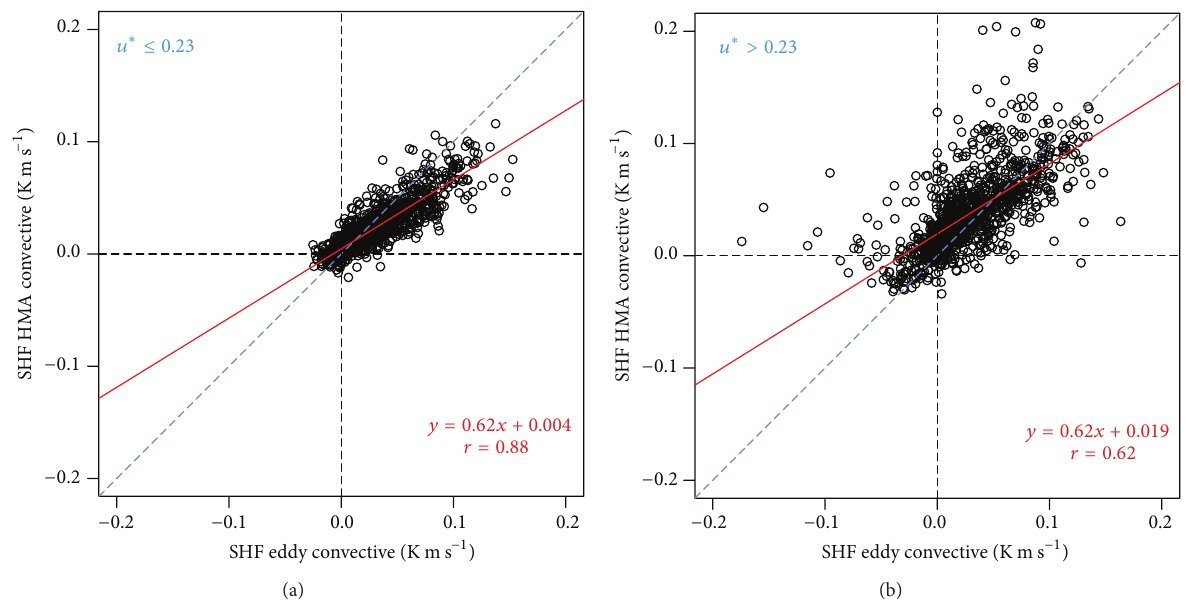
Figure 7: (a) 30 min averages of the kinematic sensible heat flux (Km s −1 ), eddy covariance versus HMA (with adapted (4)), for the time window 16.6. to 31.8. and friction velocities ≤ 0.23 ms −1 . Additionally shown is the correlation coefficient between the two data series and the linear regression (line and equation). (b) 30 min averages of the kinematic sensible heat flux (Km s −1 ), eddy covariance versus HMA (with adapted (4)), for the time window 16.6. to 31.8. and friction velocities > 0.23 ms −1 . Additionally shown is the correlation coefficient between the two data series and the linear regression (line and